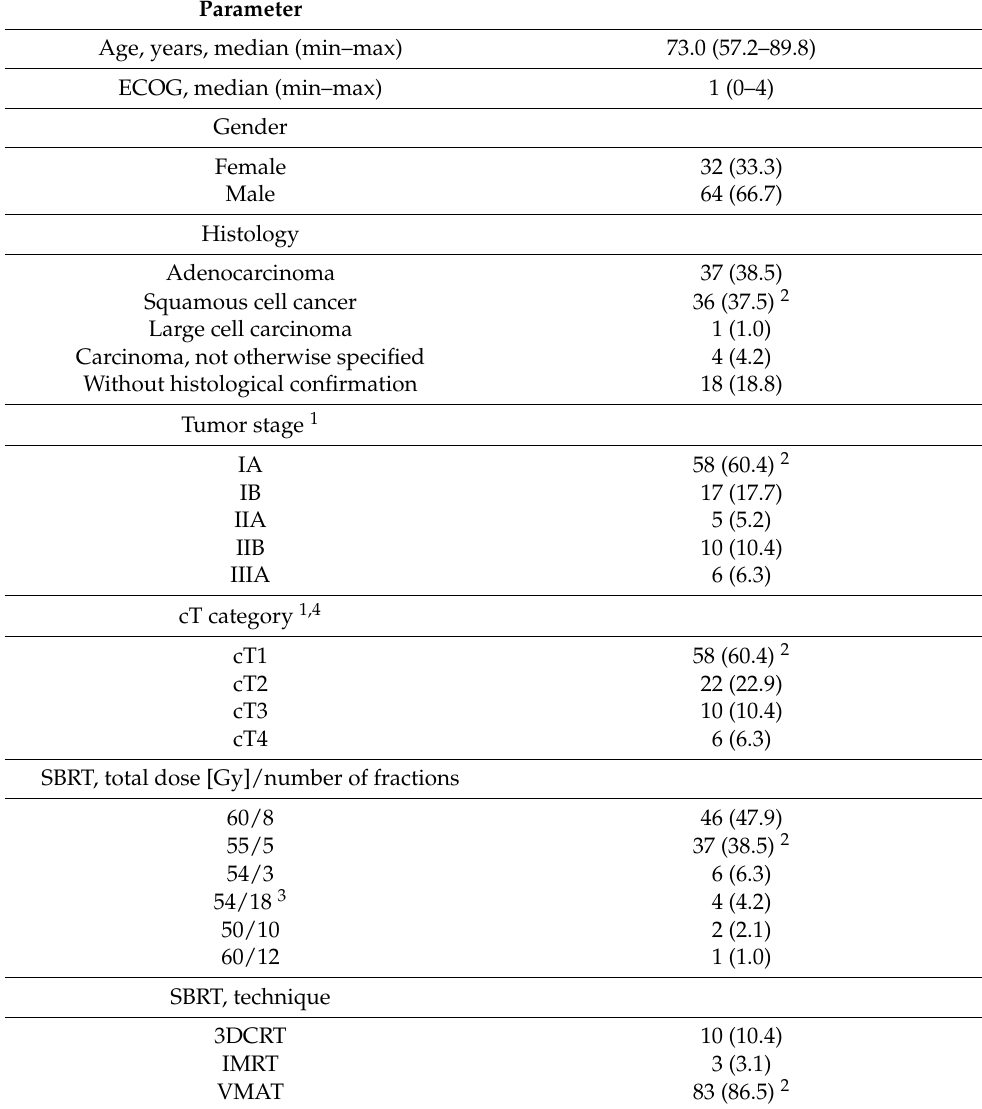
Table 1. Patient baseline characteristics. If not otherwise specified, patient numbers are given with percentage values in brackets. ECOG: eastern cooperative oncology performance status. SBRT: stereotactic body radiation therapy. 3DCRT: 3D conformal radiotherapy. IMRT: